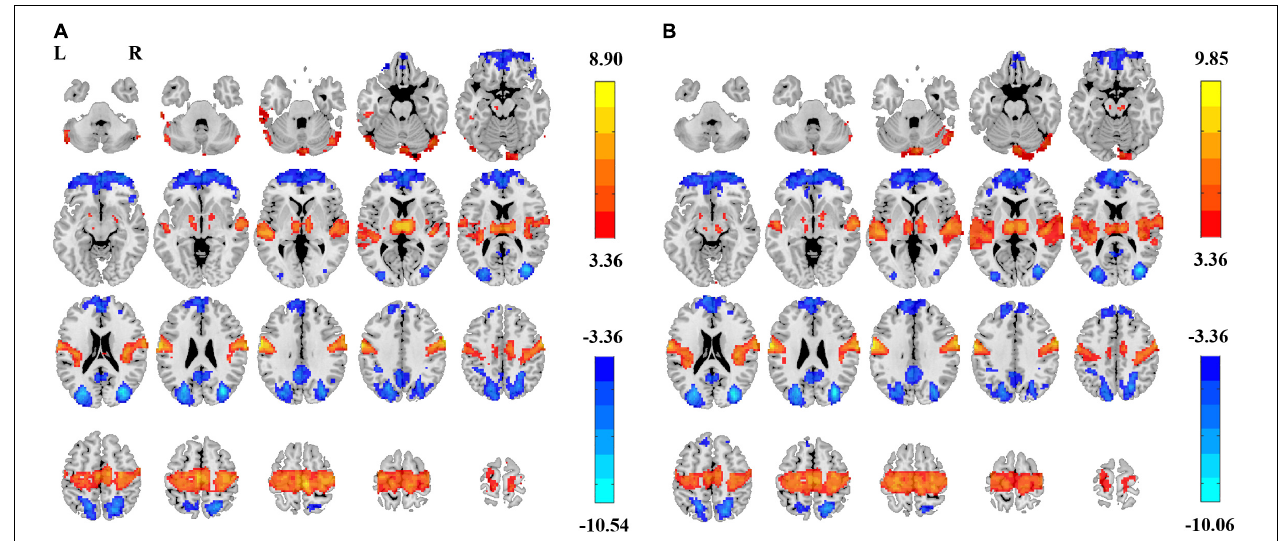
FIGURE 8 | EC–EO difference of ALFF with individual-level Z-transformation. Significant difference between EC and EO conditions of individual-level Z-transformation of ALFF in low-frequency band (0.01–0.1 Hz) [Panel (A) , GRF correction, P corrected < 0.05, |T| > 3.36, cluster size > 214 voxels] and in full